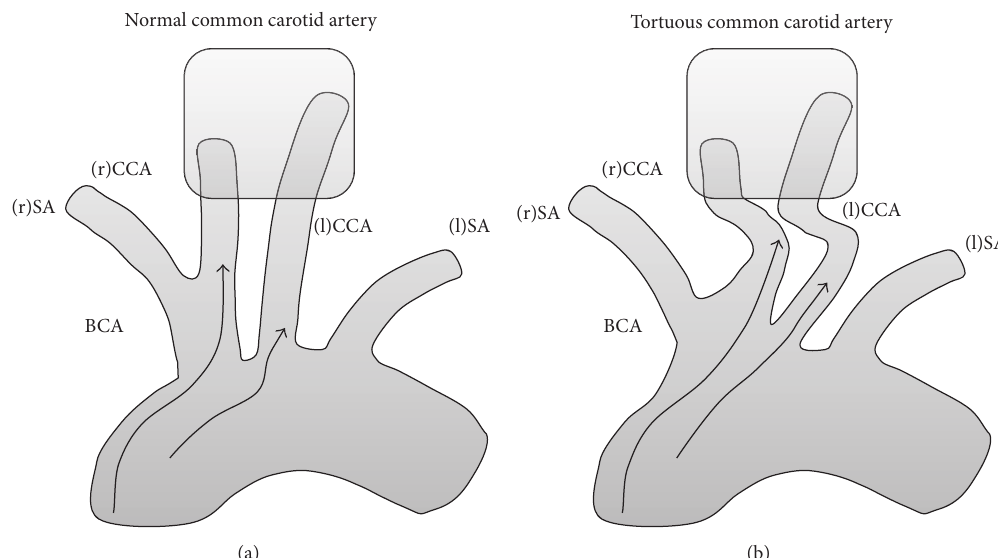
Figure 2: Relations among the carotid sheath, visceral fascia, and tortuosity. The square indicates the region of tight fusion between the carotid sheath and cervical visceral fascia. (a) Ejection power of the heart (black arrow) directly affects the brachiocephalic artery and right and left carotid arteries. (b) Ejection power of the heart (black arrow) results in tortuosity of the brachiocephalic artery and the right and left carotid arteries. BCA: brachiocephalic artery; (l)CCA: left common carotid artery; (l)SA: left subclavian artery; (r)SA: right subclavian artery; (r)CCA: right common carotid